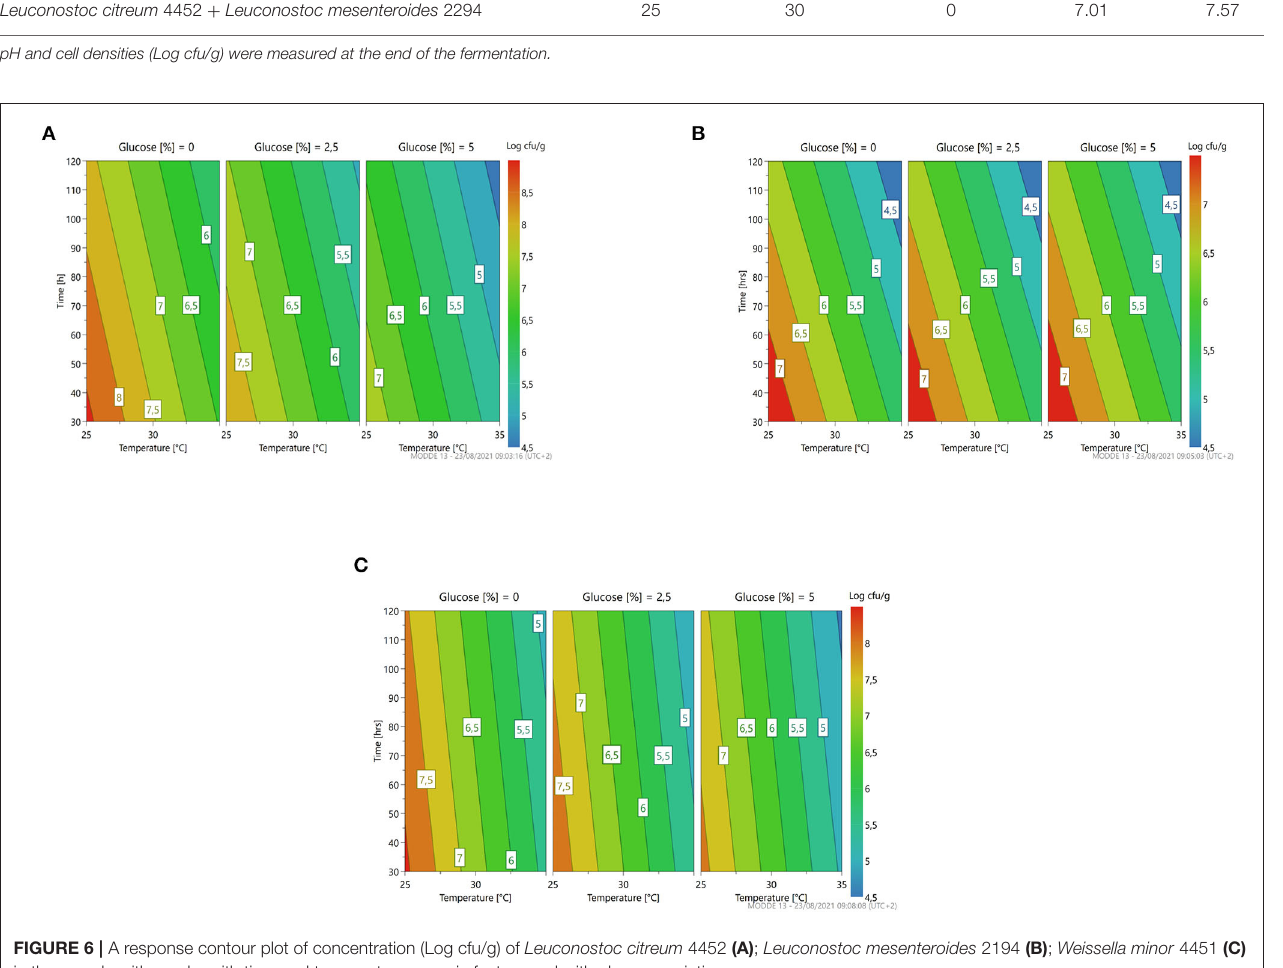
Fermentation with the co-culture of the NS vanilla beans leads to a significant increase of all the volatile compounds, and this explains the neat separation of this sample also in the PCA graph ( Figure 9 ) Vanillin content increased in the S and NS substrates after the fermentation by L. rhamnosus , in condition n.5, and by co-culture.